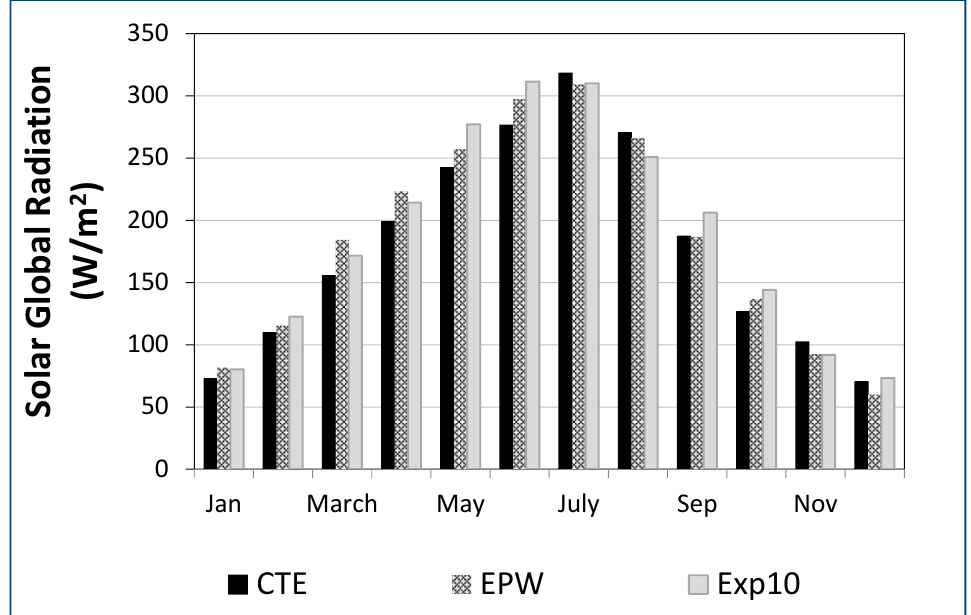
Figure 2. Annual evolution of Solar Global Radiation obtained for the three climate databases of Madrid: CTE, EPW and Exp10.